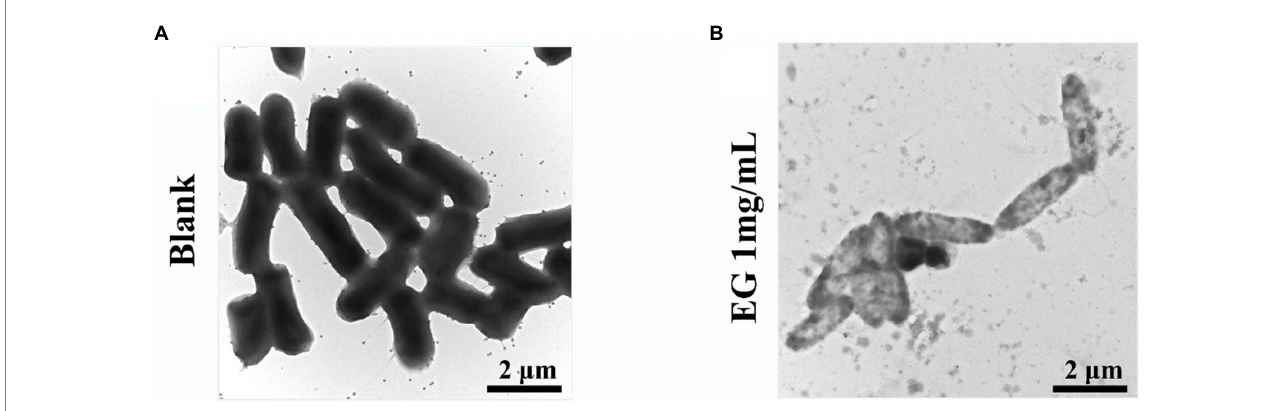
FIGURE 4 The structural integrity of bacteria membrane under TEM (15000×): (A) blank; (B) EG-treated CRKP strains.